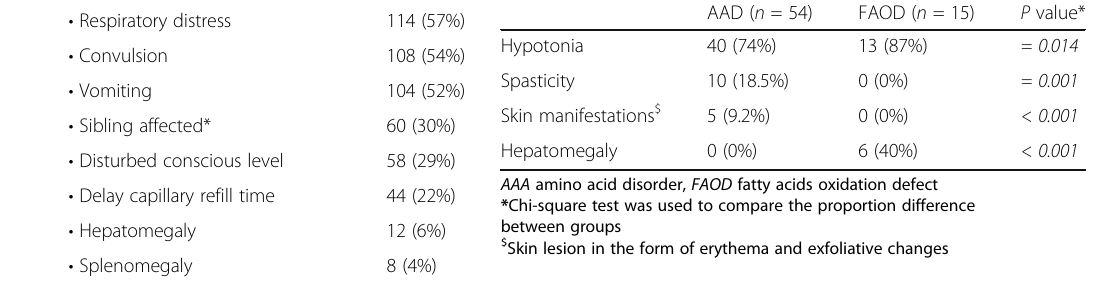
Table 4 The difference between the commonly diagnosed cases in our study (AAD and FAOD) in relation to hypotonia, spasticity, skin manifestations, and hepatomegaly